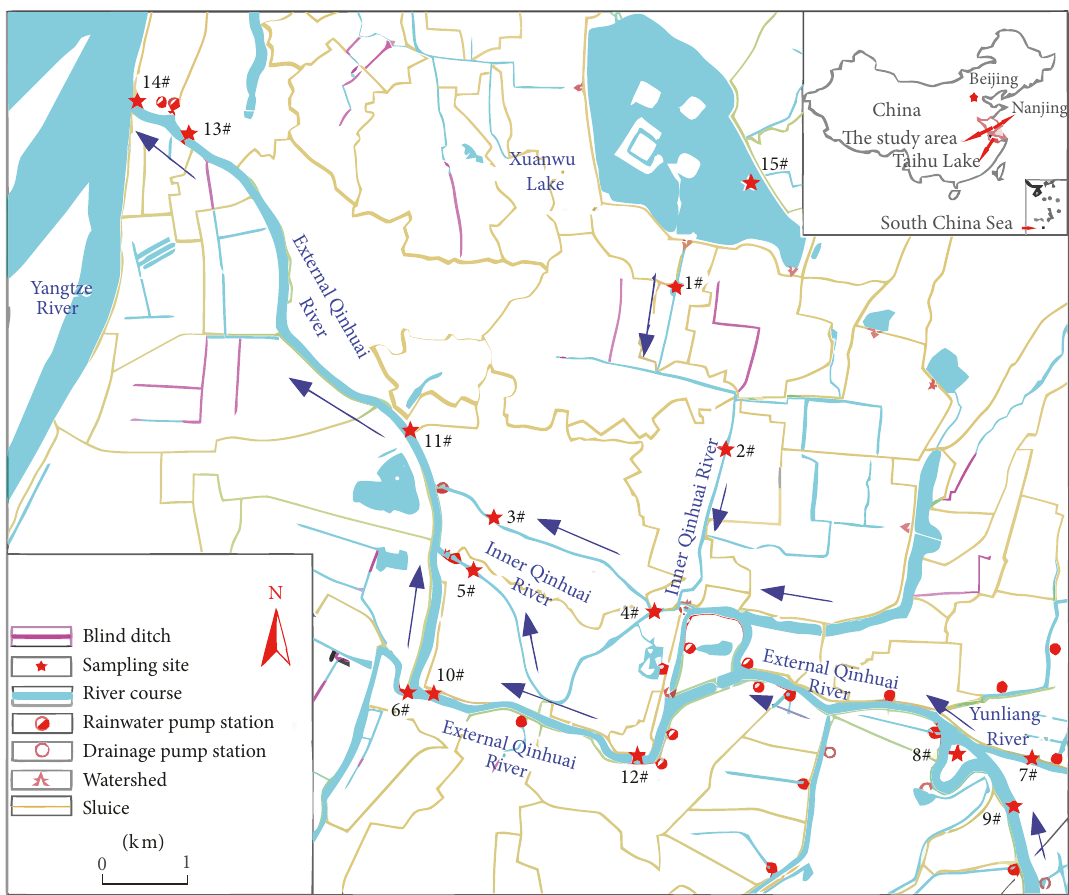
Figure 1: Sampling sites in the study area in Nanjing City, China. The codes for each sampling site are given in Table